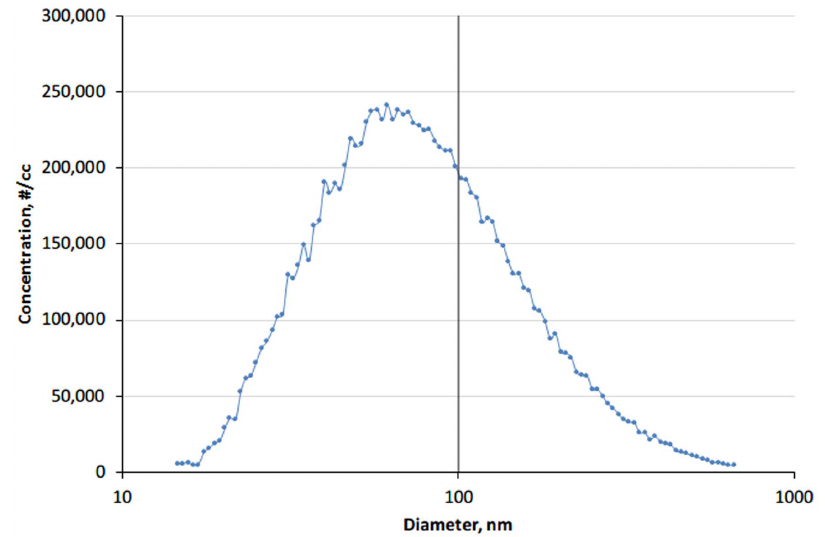
Figure 4. Particle number size distributions of the NaCl aerosol particles measured by SMPS. The vertical solid line indicate a particle diameter of 100 nm.